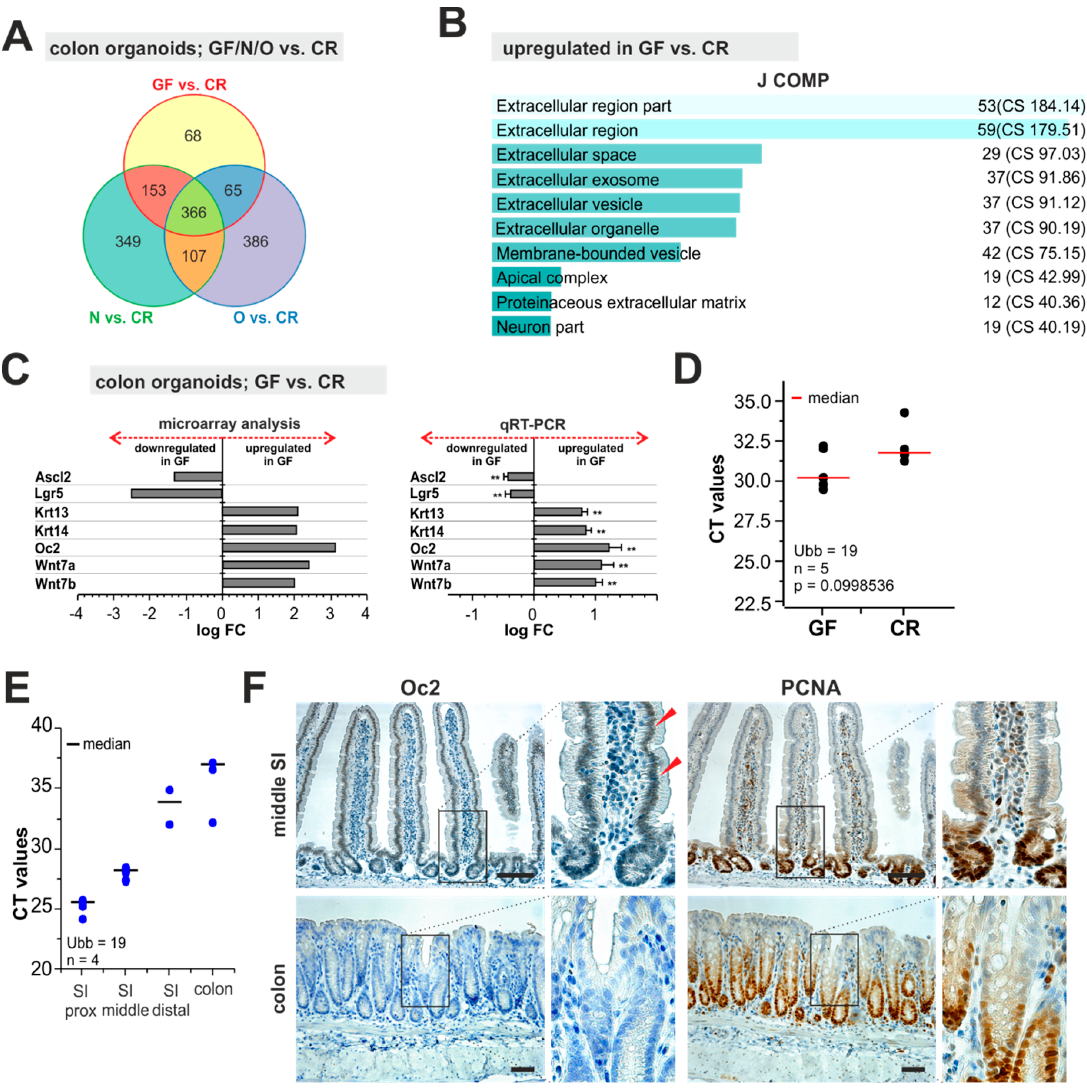
Figure 4. Oc2 expression was elevated in organoids derived from the gnotobiotic colon ( A ) A Venn diagram comparing gene expression profiles of colon organoids derived from GF, N, and O animals when compared to colon organoids derived from CR mice; 366 gene probes representing 285 annotated genes were identified. The genes are listed in Supplementary Table S6. ( B ) Enricher analysis of 138 genes upregulated in GF vs. CR colon organoids. The diagram shows top ten categories of the Jensen Compartment (J COMP; https://compartments.jensenlab.org/Search). ( C ) Validation of cDNA microarray by qRT-PCR. Diagrams depict expression analysis of the indicated genes in GF vs. CR colon organoids performed by cDNA microarray hybridization (left) or by qRT-PCR analysis (right). Normalized fluorescence signal obtained in the respective gene probe upon hybridization with RNA isolated from CR mice was set to 1. Results of the qRT-PCR analysis were normalized to Ubb ; the expression level of the respective gene in the mucosa of CR mice was set to 1. Organoids derived from at four two mice were used; qRT-PCR reactions were run in technical triplicates. Error bars represent SDs. Corresponding CT values are listed in Supplementary Table S4; ** p < 0.01 (one-way ANOVA test). ( D ) Expression of the Oc2 gene in the colon mucosa of CR and GF mice. Results were normalized to Ubb and the cycle threshold (CT) value of Ubb was arbitrarily set to 19. Five mice from each group were analyzed; median of CT values is indicated by a red line. The indicated p value was calculated using a one-way ANOVA test. ( E ) Oc2 expression levels along the rostro-caudal axis of the intestine. The diagram shows results of qRT-PCR using total RNA isolated from the mucosal scratches of the proximal (SI-prox), middle (SI-middle) and distal part (SI-distal) of the small intestine and from the middle portion of the colon of CR mice. Total RNA was obtained from 4 animals. Results were